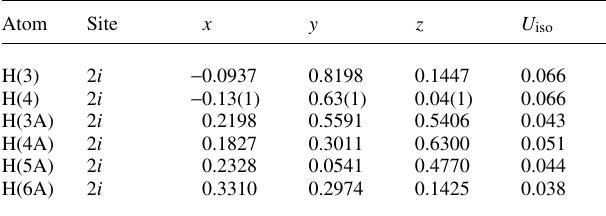
Table 2. Atomic coordinates and displacement parameters (in Å 2 )